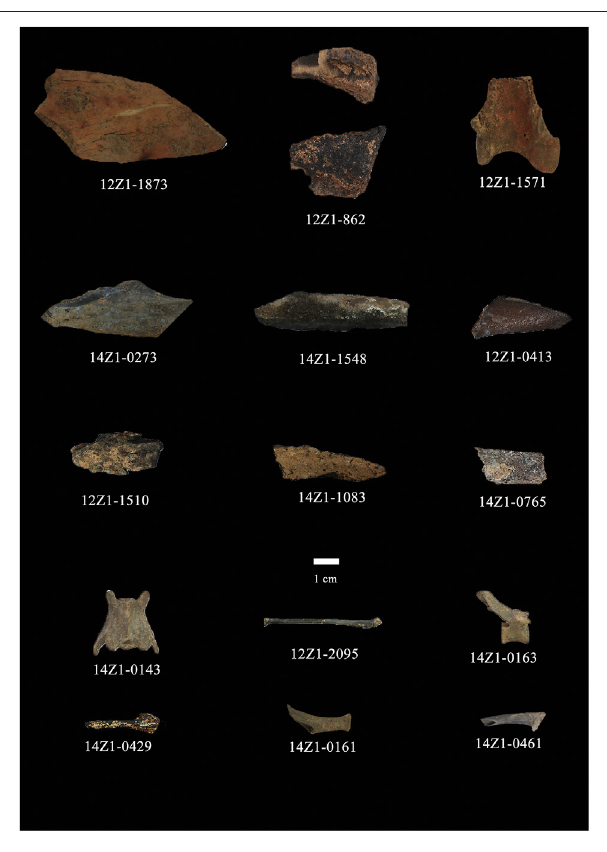
FIGURE5| Appearance ofbonesampleswithCIvalues < 0.3,indicating the samples were probably heated to temperatures lower than 600 ° C.